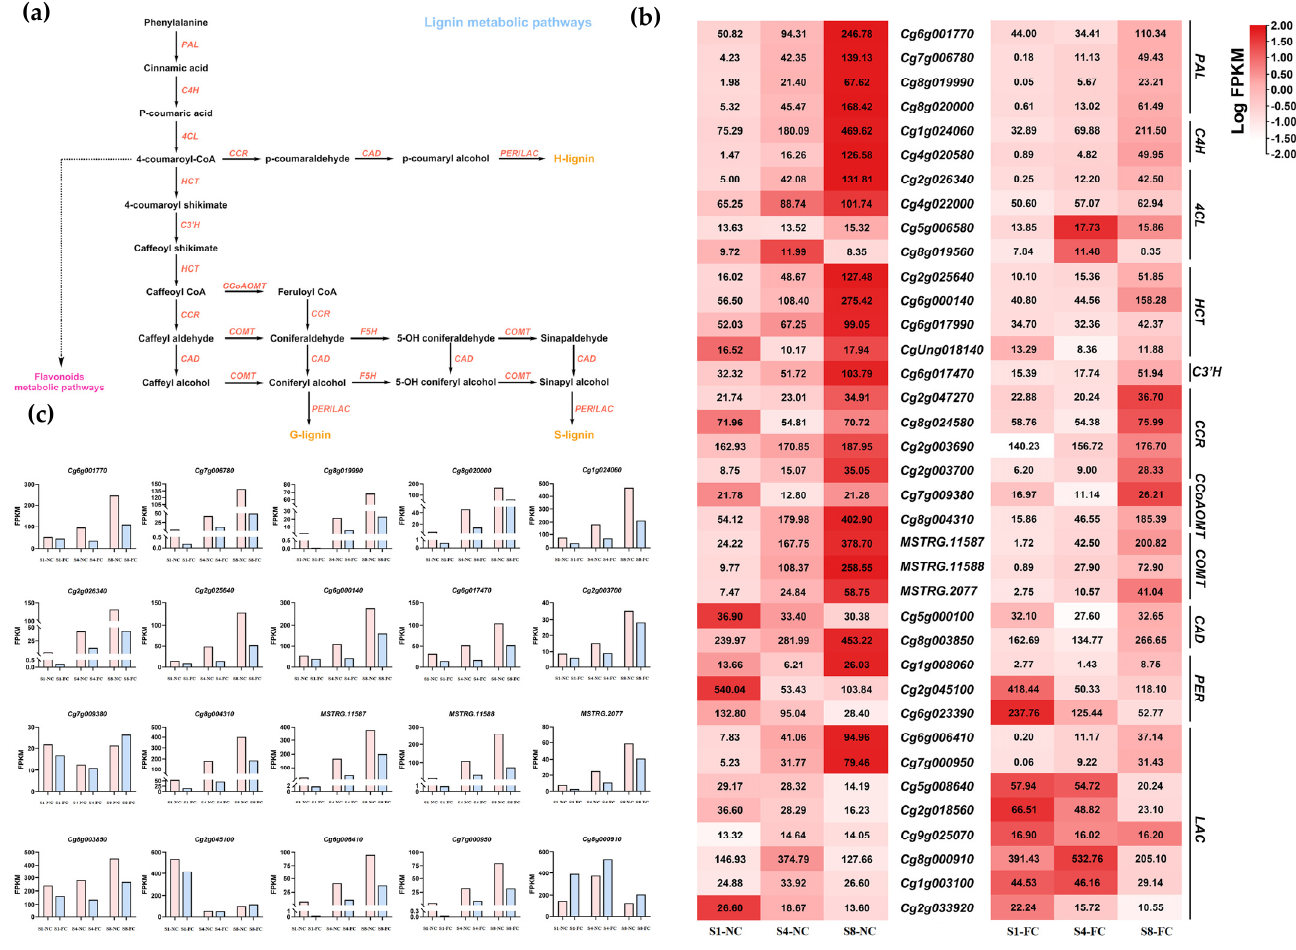
Figure 5. ( a ) The lignin metabolic pathway in pomelo; ( b ) Heatmap of lignin biosynthesis genes in NC and FC juice sacs at three stages; ( c ) The expression level of 20 DEGs related to lignin metabolism was based on the FPKM value. FPKM values were the means of three